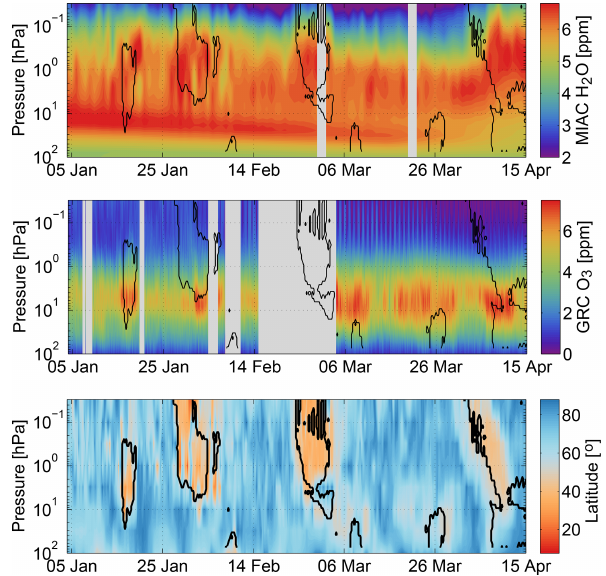
Figure 14. Time series of MIAWARA-C water vapour, GROMOS- C ozone and latitudinal origin of the air at Ny-Ålesund calculated with LAGRANTO 3d backward trajectories. The black contours in- dicate when the polar vortex edge is above Ny-Ålesund. When the polar vortex shifts away from Ny-Ålesund, water vapour increases are measured because air masses arrive from the midlatitudes. In the ozone measurements an increase in stratospheric ozone dur- ing the first two vortex shifts in January and February is visible. In March the ozone increases in the middle stratosphere are less clearly linked to these shifts than during the period of polar night in